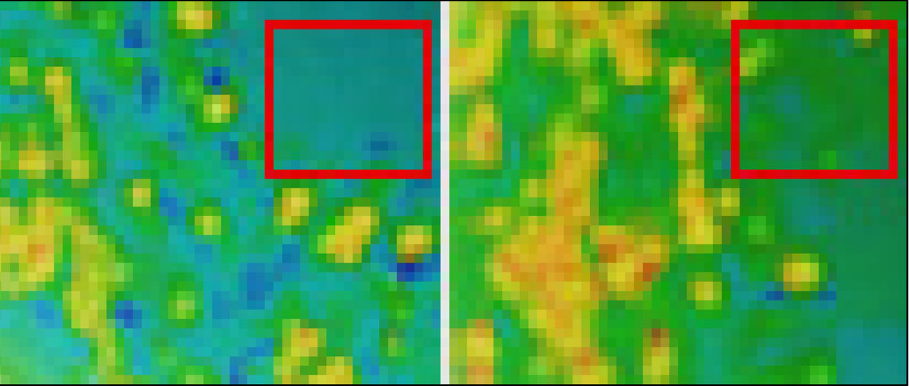
Figure 14. Scattering configuration of bacteria CFUs on the petri dish before and after plasma treatment for 5 min: Staphylococcus aureus (left image) and Escherichia coli (right